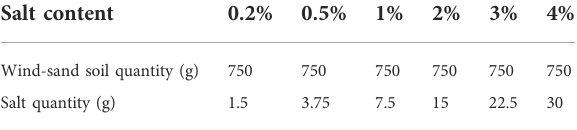
TABLE 2 Quantity of crystalline salt at different salt content.